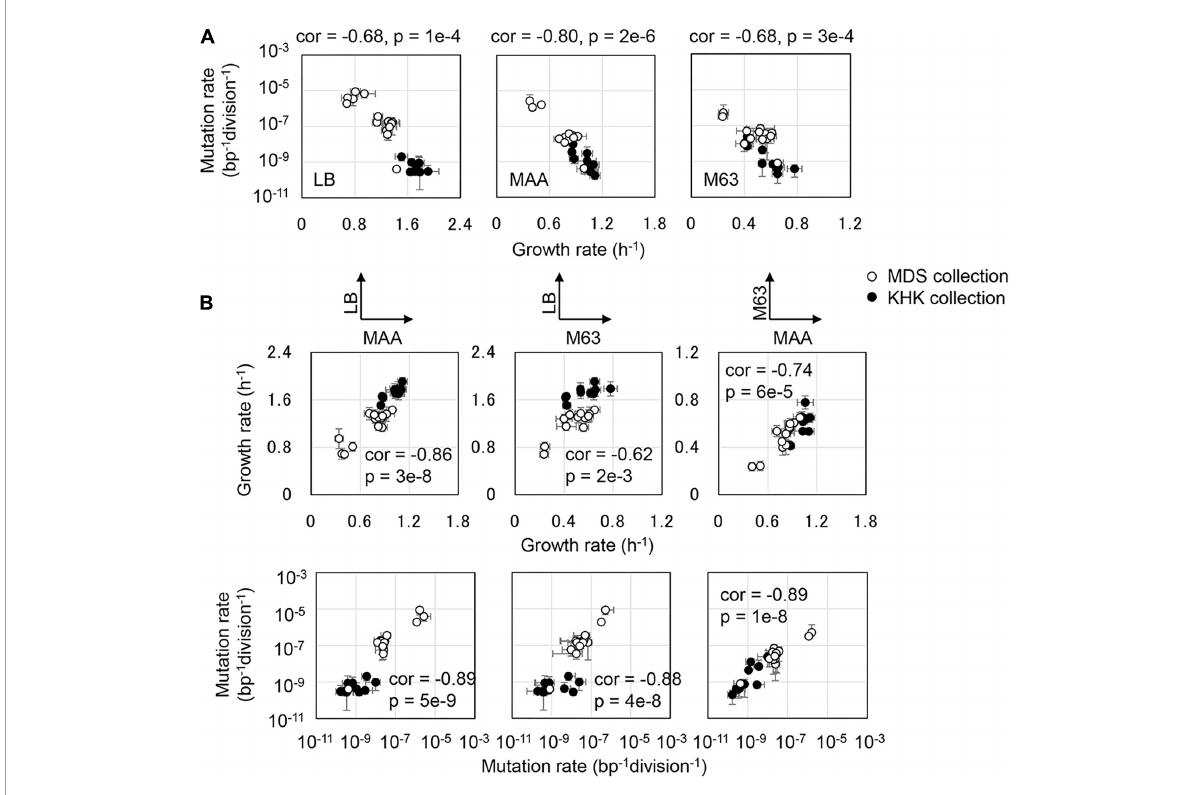
FIGURE2 Coordinated changes in mutation and growth rates. (A) Correlation between growth rate and mutation rate in the defined medium. Pearson correlation coefficients, the p values, and the media are indicated. (B) Correlated changes of the mutation and growth rates in various media. The upper and bottom panels show the correlated changes in growth and mutation rates between any two different media, respectively. Open and closed circles stand for the collection of MDS and KHK collections,